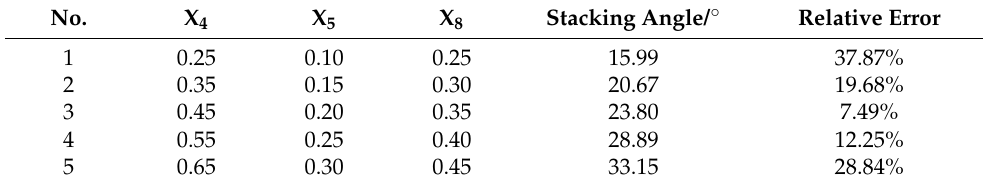
Table 6. The steepest ascent test and the